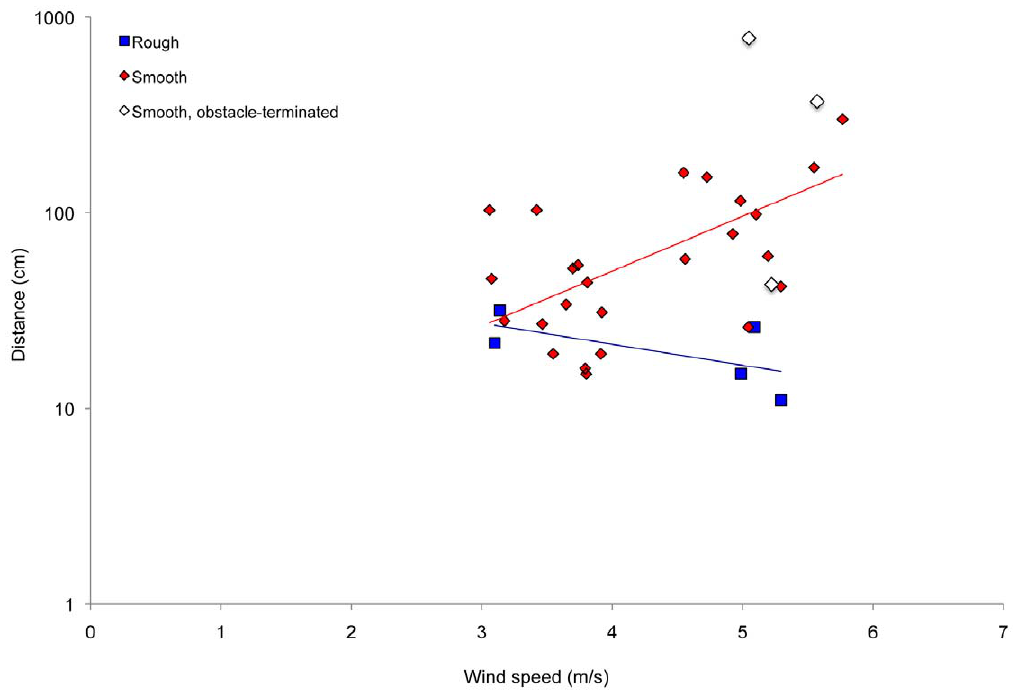
Figure 6. Effect of wind speed and beach roughness on distances wheeled by C.dorsalismedia larvae. Open diamonds represent larvae on smooth substrate whose wheeling bouts were truncated by encounters with isolated obstacles.